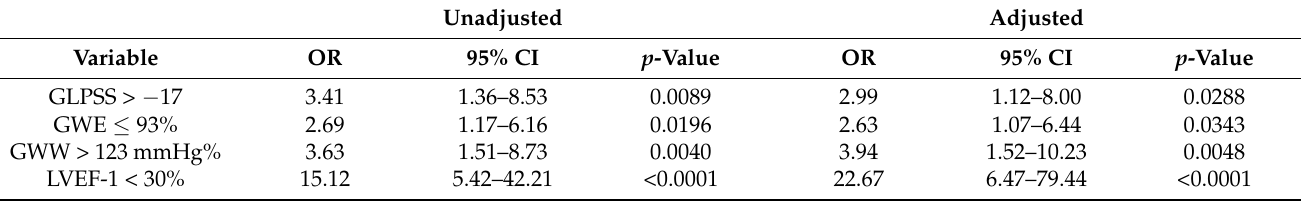
Table 7. Univariate logistic regression for the risk of CAD with normal LV contractility and LVEF > 50% unadjusted and adjusted for participants’ age, gender, and body mass index. Unadjusted